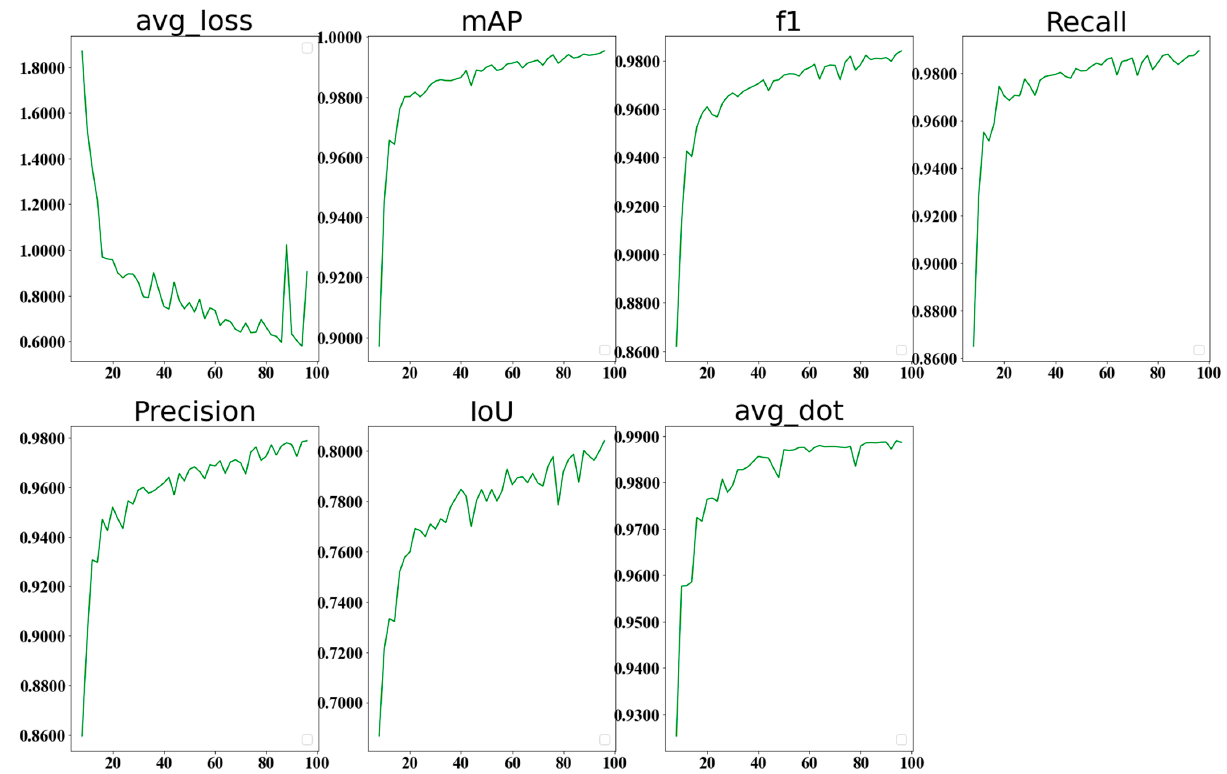
Figure 11. The changes of various indicators of UCAS-AOD data set during iteration.